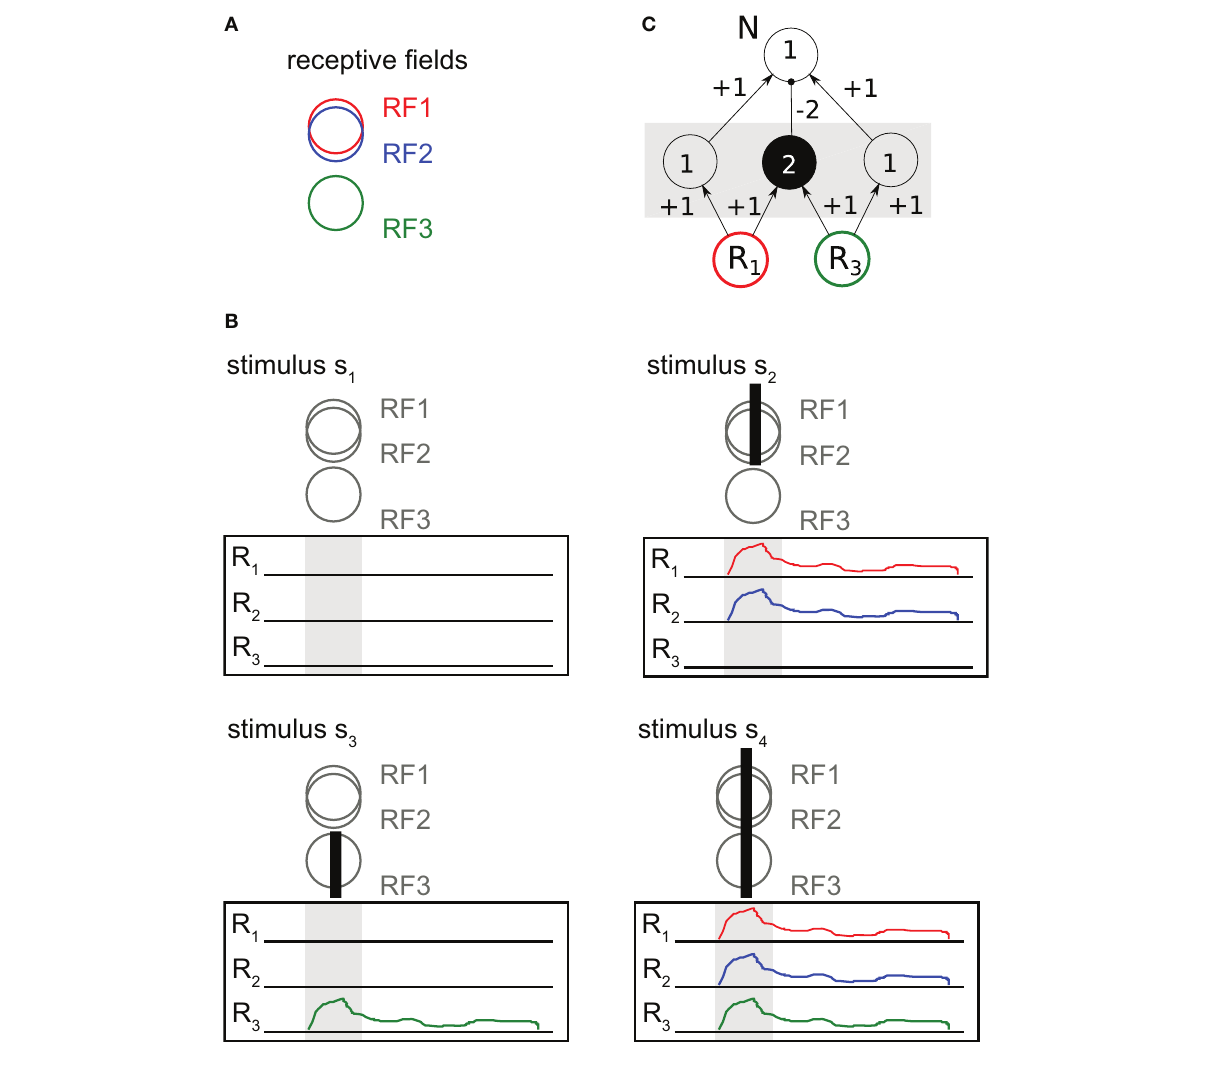
the hidden circuit in between R 1 , R 2 , and N open circles denote excitatory neurons, filled circles inhibitory neurons. Numbers in circles are activation thresholds, signed numbers at connecting arrows are synaptic